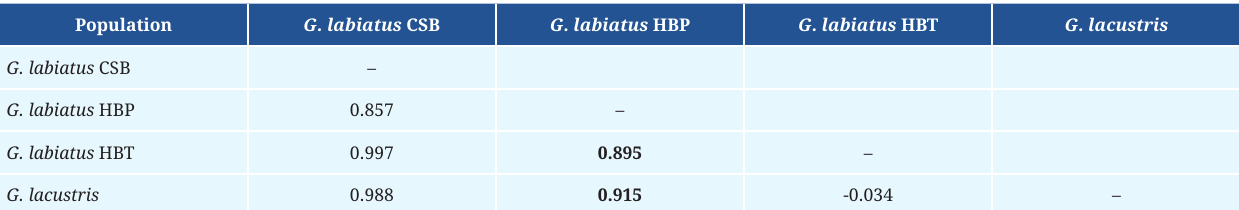
TABLE 2 | Genetic structure ( F